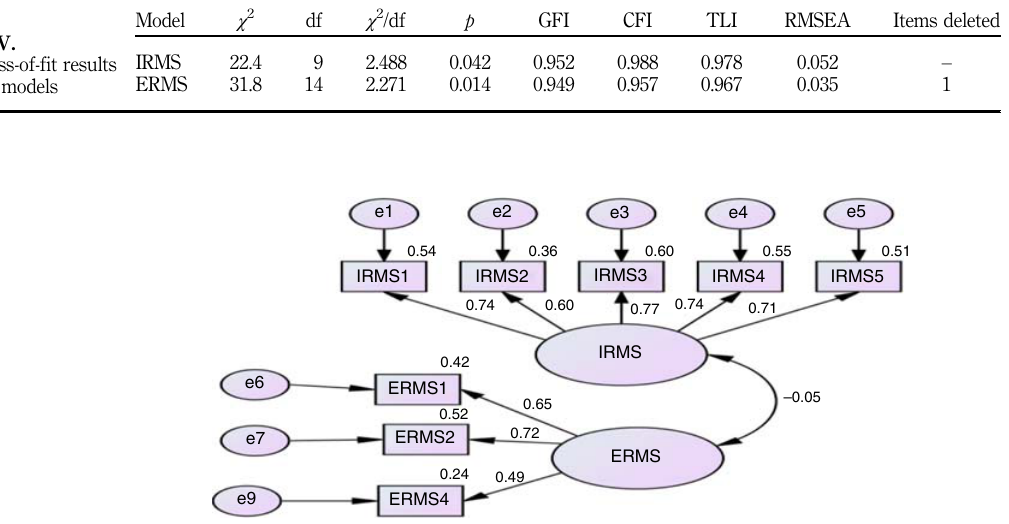
Figure 4. Measurement model for role